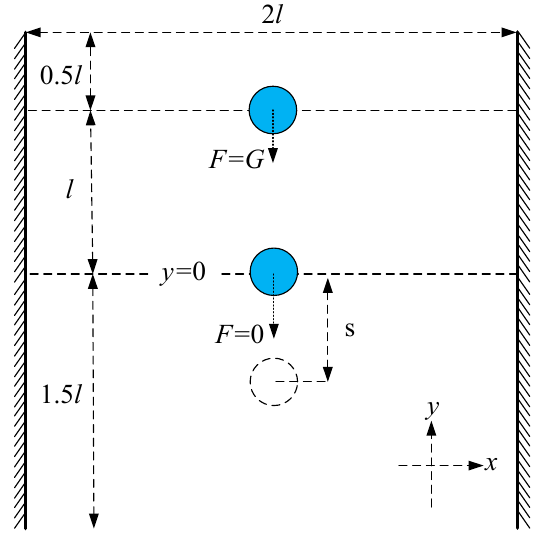
Figure 5. Inertial force validation model.